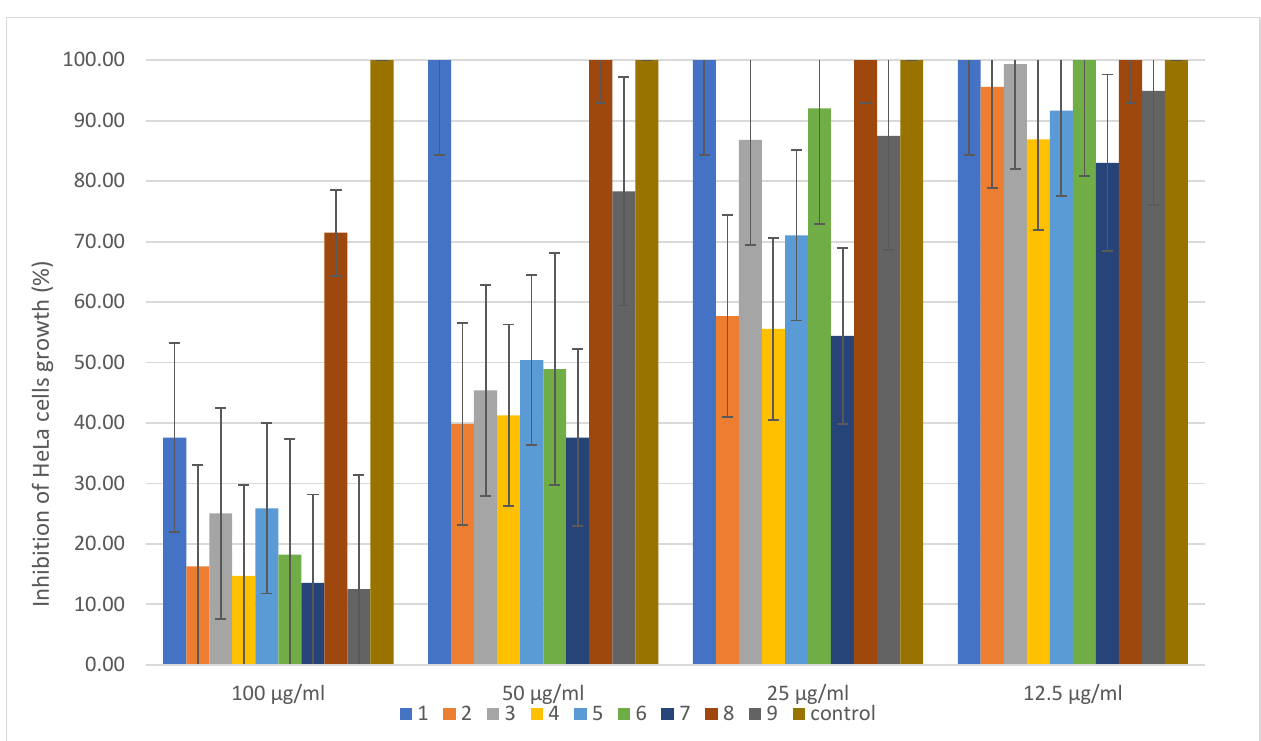
Figure 9. Graphic representation of the cytotoxicity assay on HeLa cells.